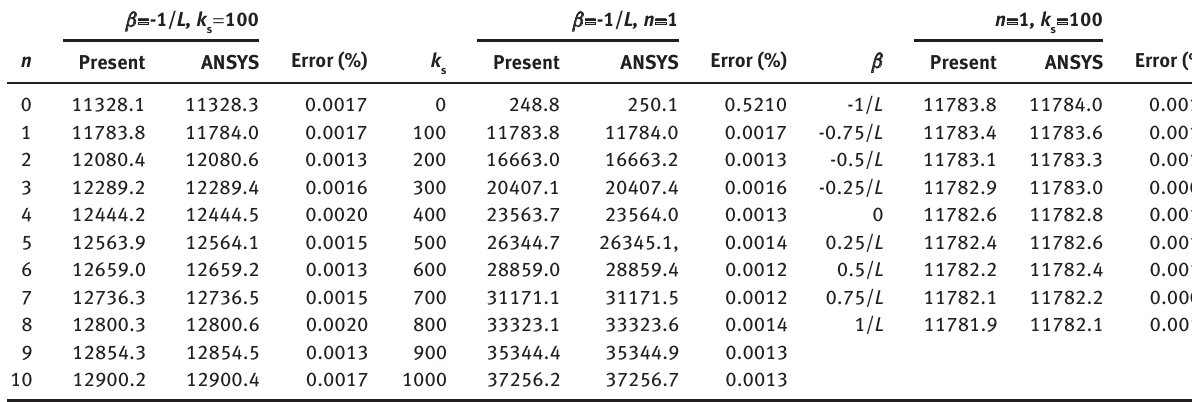
Table 2 Comparison of the results of the present and ANSYS for CF boundary